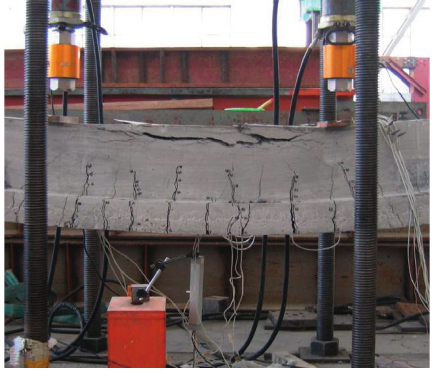
Figure 12: Cracked test beam SCB-1.